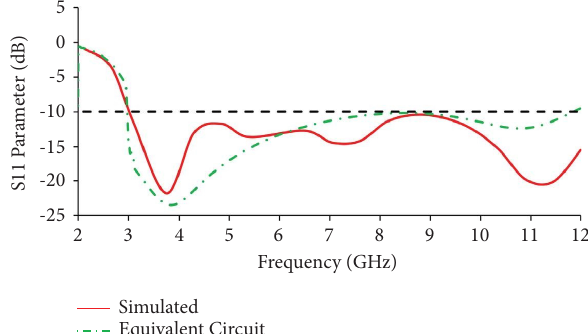
Figure 7: Refection coefcient comparison of simulated and equivalent circuits.